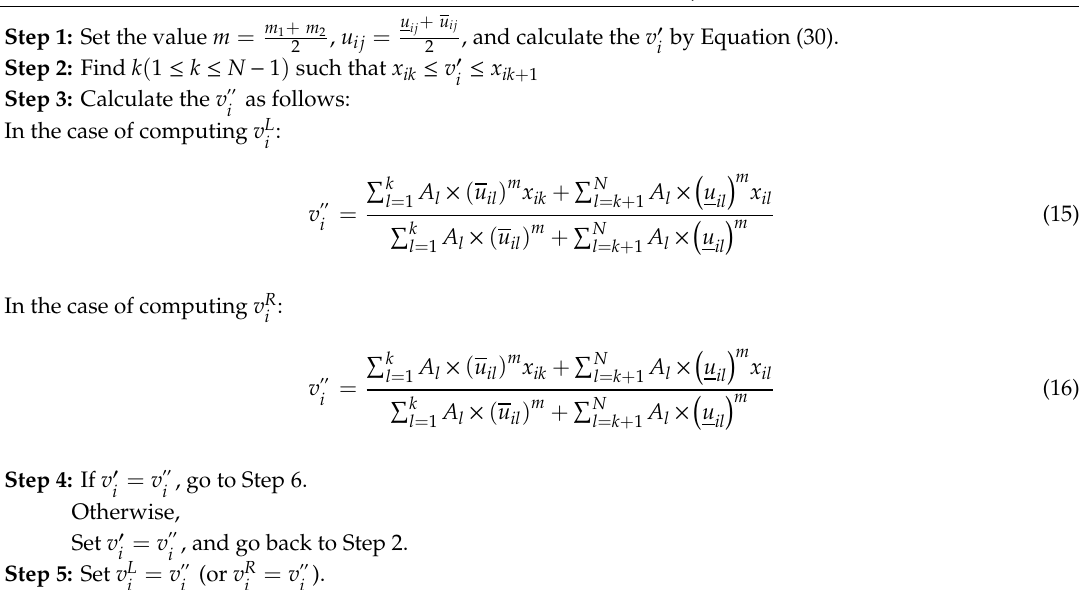
Algorithm 1 . The area-weighted KM algorithm for SW-IT2FCM-O ( u